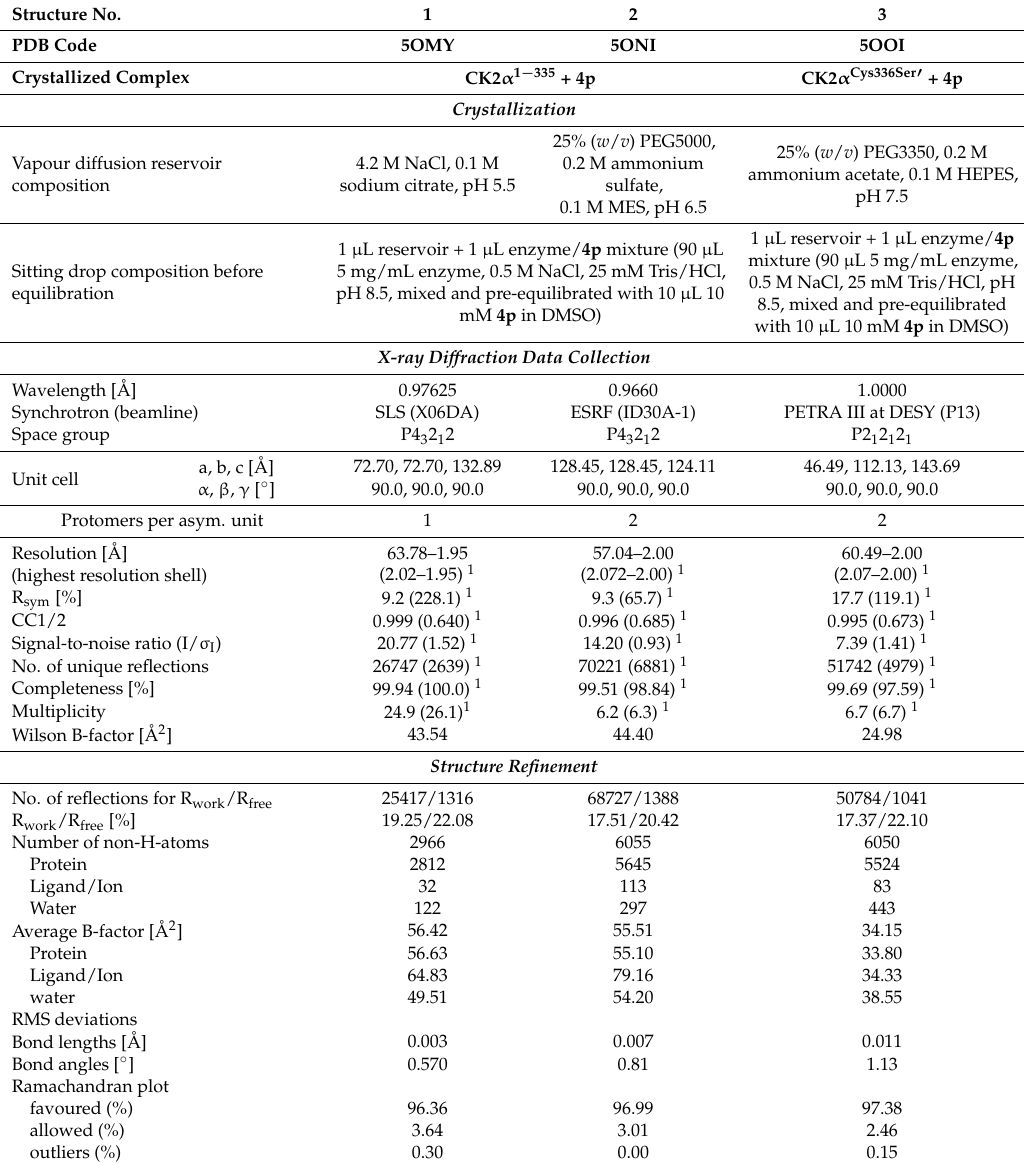
Table 1. Crystallization, X-ray diffraction data and refinement